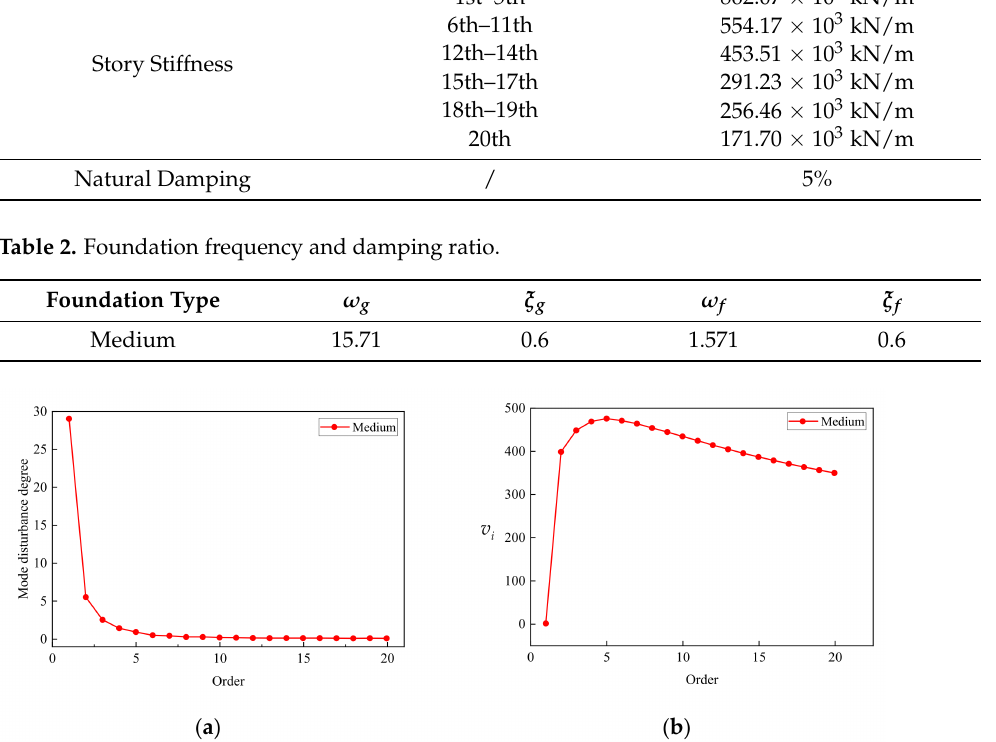
Figure 2. Modal disturbance degree and its evaluation index under medium soil condition: ( a ) Modal disturbance degree; ( b ) v i